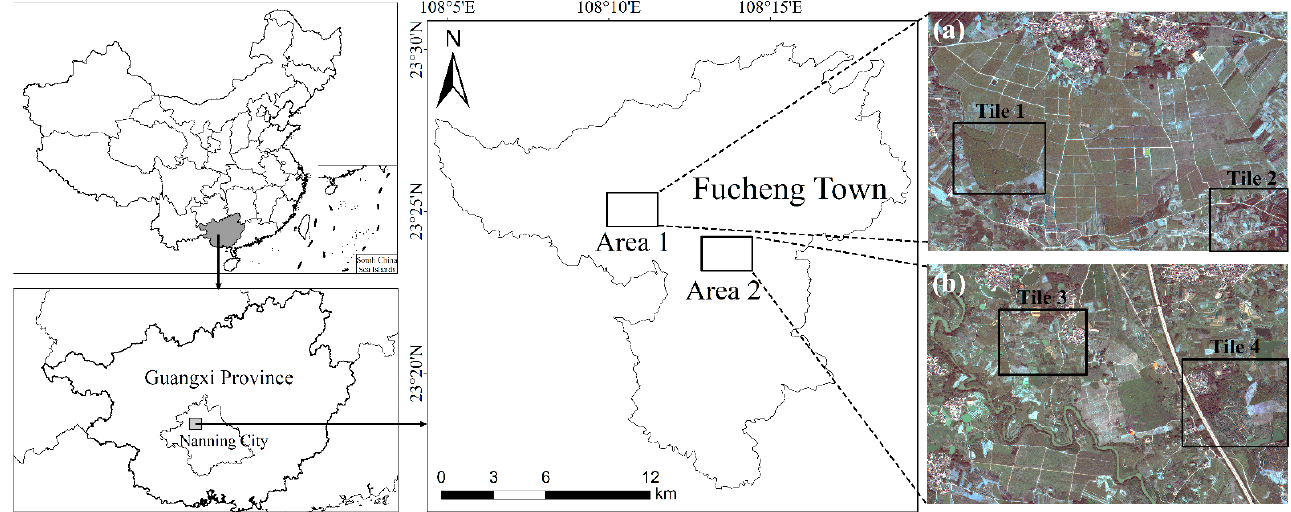
Figure 3. The study areas were located in Fucheng Town of Nanning City, Guangxi Province of China. Area 1 ( a ) and Area 2 ( b ) are locations used for assessing the flexibility of the GP approach, and Tiles 1–4 are easily misclassified and are used for additional comparisons and analysis.